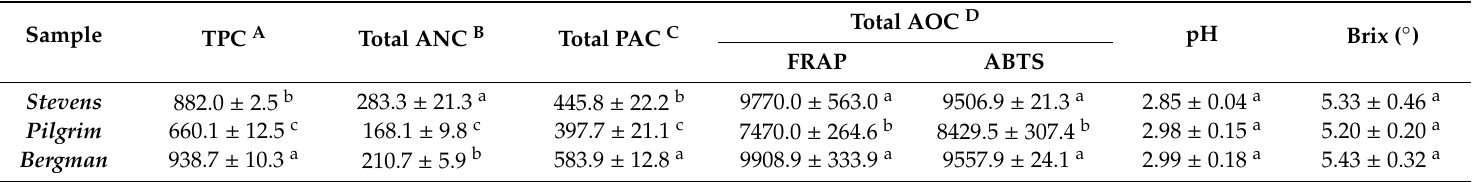
Table 1. Total phenolic (TPC), anthocyanin (ANC), proanthocyanin (PAC) contents and antioxidant capacities (AOC) of the juice samples determined by spectrophotometric assays.